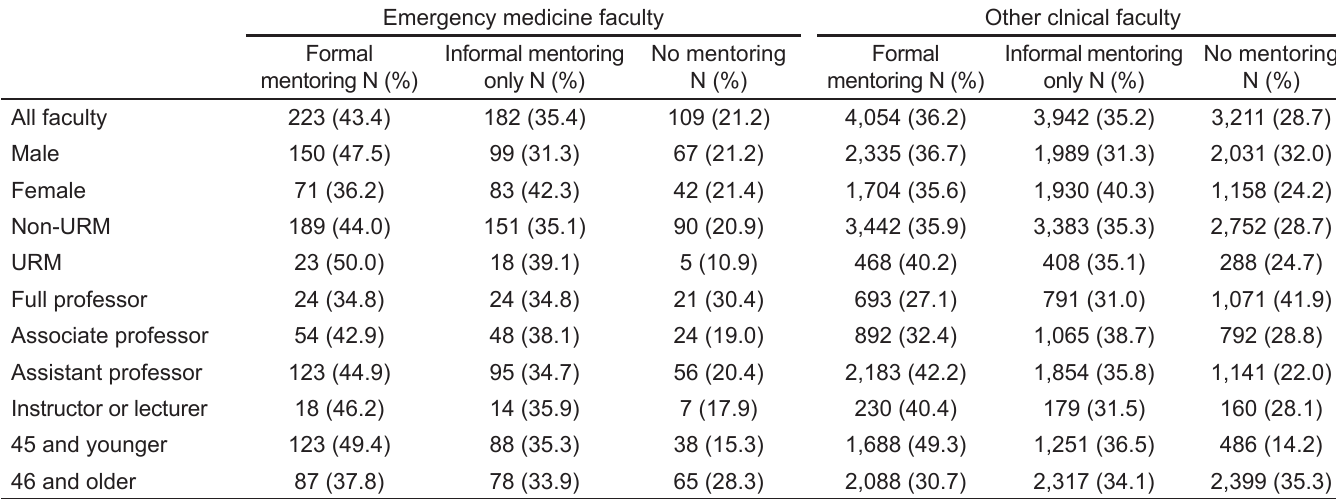
Table 3. Faculty mentoring status by